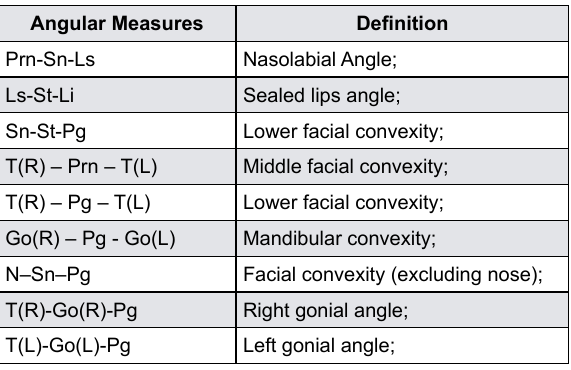
Angular Measures